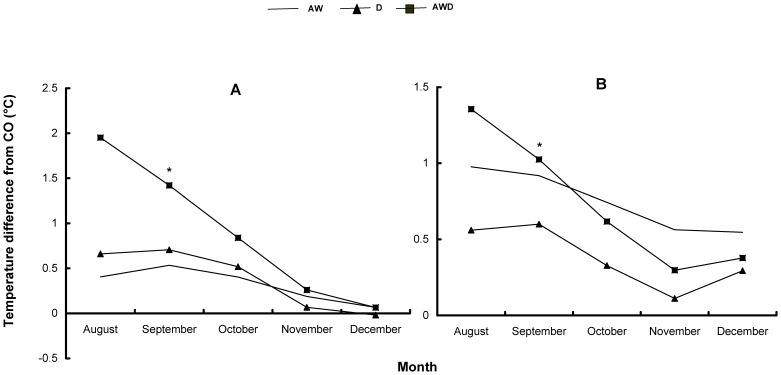
Effects of climate treatments and soil types on soil surface temperature.Mean surface temperature relative to controls (CO) in acid (A) and calcareous (B) soils as affected by the treatments: AW = air warming, D = drought, and AWD = air warming + drought in 2007, where * indicates a significant difference from CO (P<0.05, n = 4).